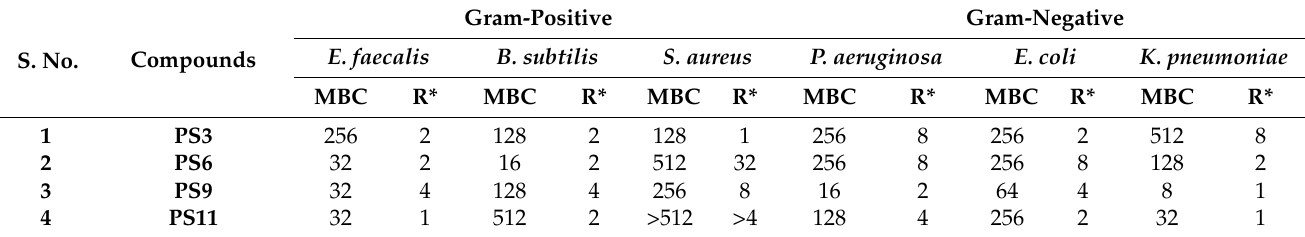
Table 4. MBC ( µ g/mL) and MBC/MIC (R*) ratio of the compounds.